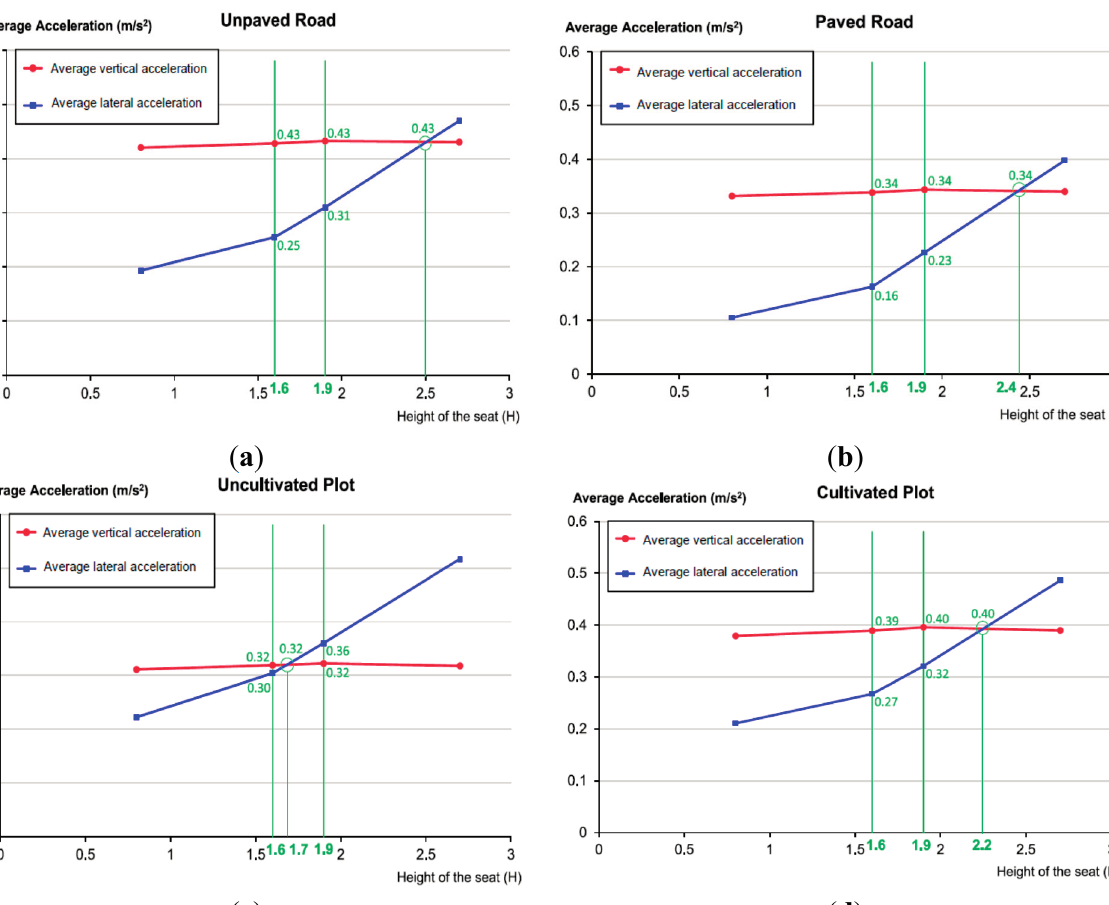
Figure 8. Transmission factors on the z and the y -axis geometrically computed in Section 3 (green color) versus mean acceleration on the 1–7 Hz frequency band (red color) obtained experimentally on paths along the paved road ( a ); the unpaved road ( b ); the cultivated plot ( c ); and the uncultivated plot ( d ) for the four tractor-seat heights (0.8, 1.6, 1.9, and